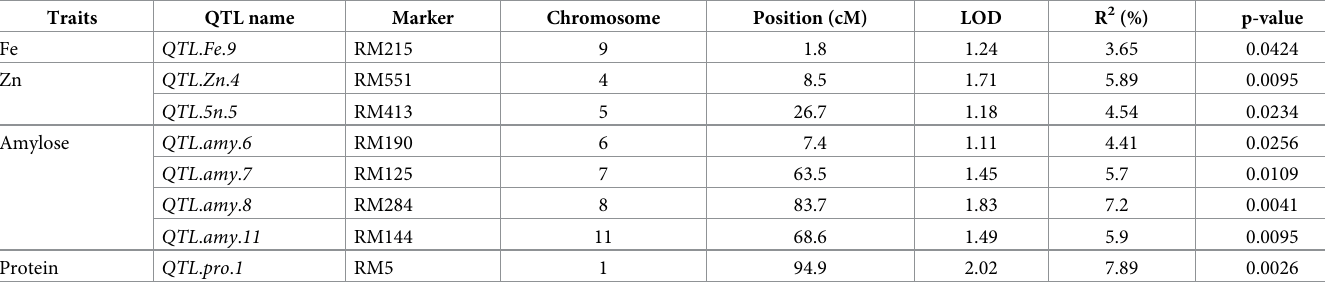
Table 2. Significant marker-trait associations indicating quantitative trait loci for Fe, Zn, amylose and protein content in 113 rice genotypes. Traits